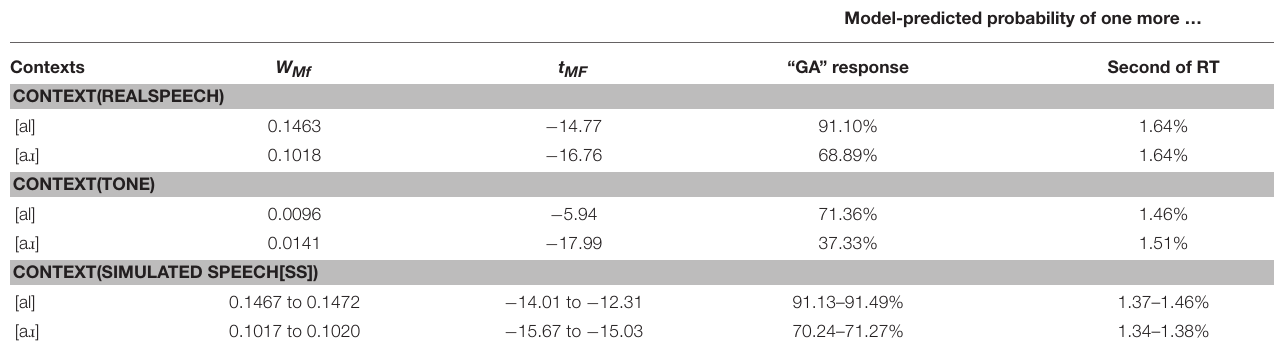
TABLE 1 | Multifractal properties of contexts by type and by precursor, with model-predicted logarithmic-probability of one more “GA” response and model-predicted response time (RT).